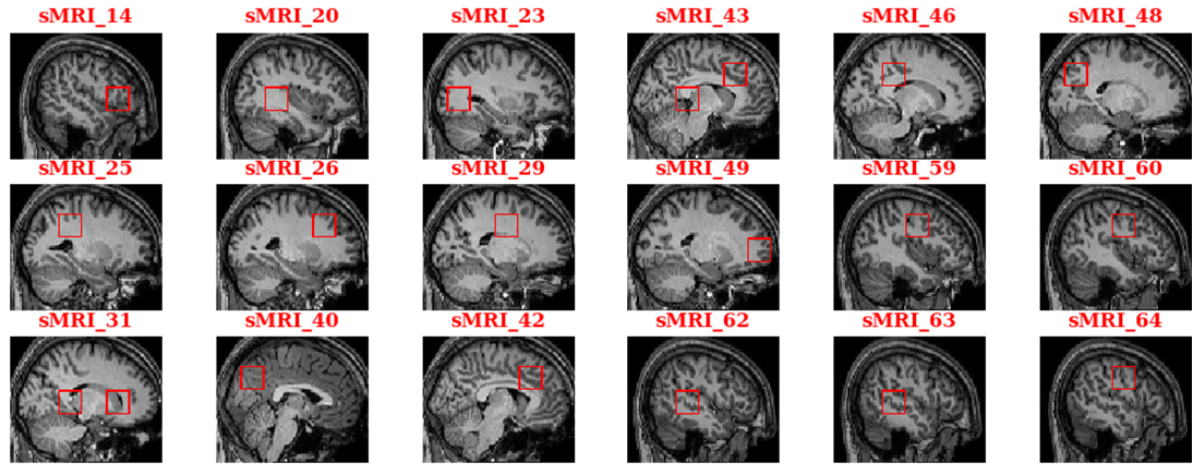
Figure 7. Annotation of the autism spectrum disorder–related brain regions for a sample in the ETH dataset. sMRI: structural magnetic resonance